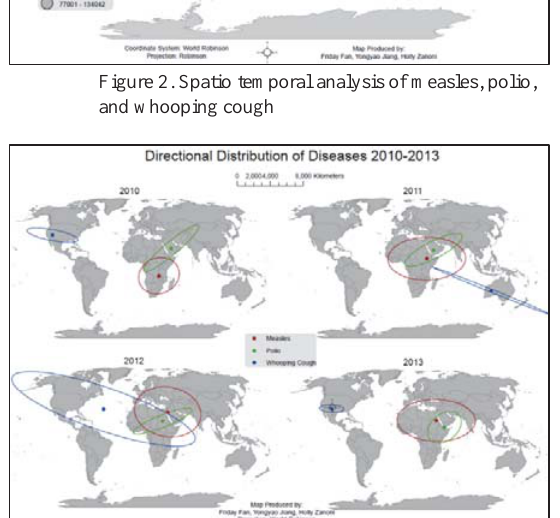
Figure 3. Directional distribution measles, polio, and whooping cough